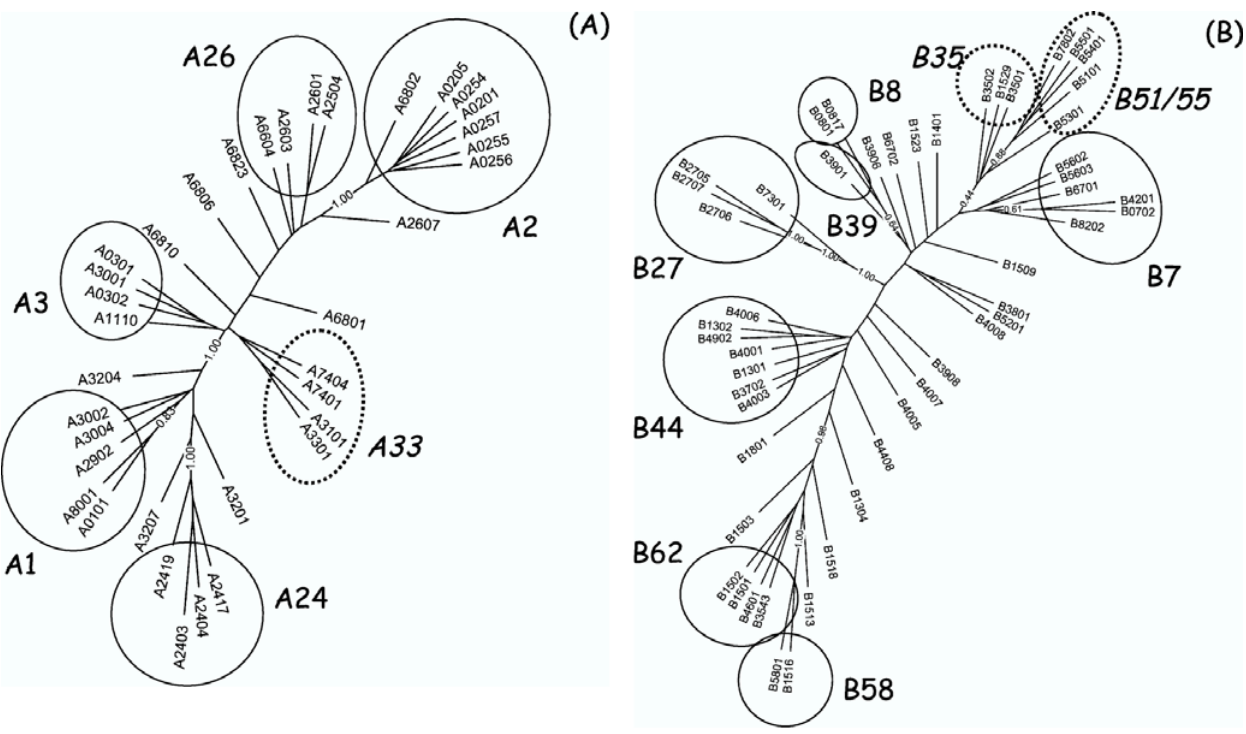
Figure 3. HLA clustering from NetMHCpanpredictions. The left hand panel shows the clustering for 36 representative HLA-A alleles, and the right hand panel the clustering for 51 representatives HLA-B alleles. The trees are generated using the neighbor-joining algorithm from HLA distance matrices as described in the text. The 12 common supertypes are highlighted in full line circles. The proposed novel (sub)-supertypes are highlighted in dotted